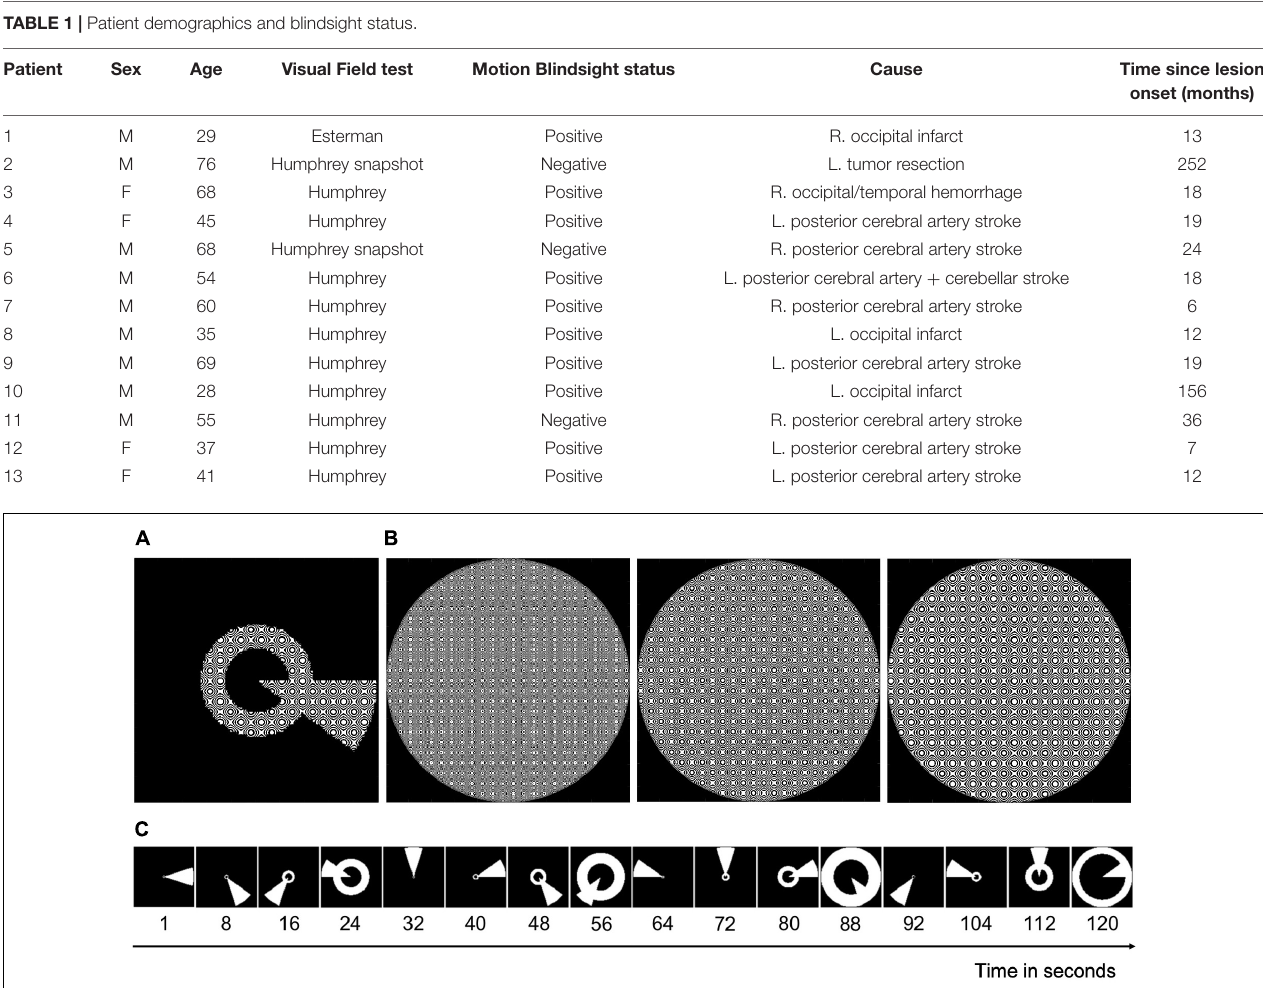
FIGURE 1 | An illustration of the stimulus. (A) Image of the combined wedge-ring stimulus with the carrier (see B ). (B) The stimulus carrier, a dynamic high-contrast pseudo-checkerboard pattern that varied in spatial frequency and phase. (C) Static binarized images of every 8th second of a full stimulus cycle of 120 s. During Scan 1, this cycle was repeated twice followed by a blank period of 48 s. During Scan 2, the cycle reversed, yet with the wedge starting again at 3 o’clock.